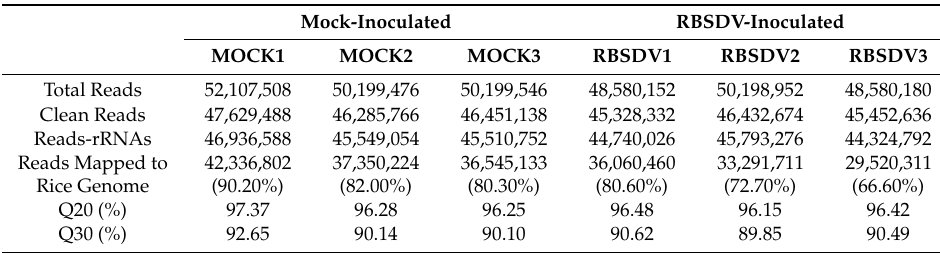
Table 1. Summary of RNA sequencing